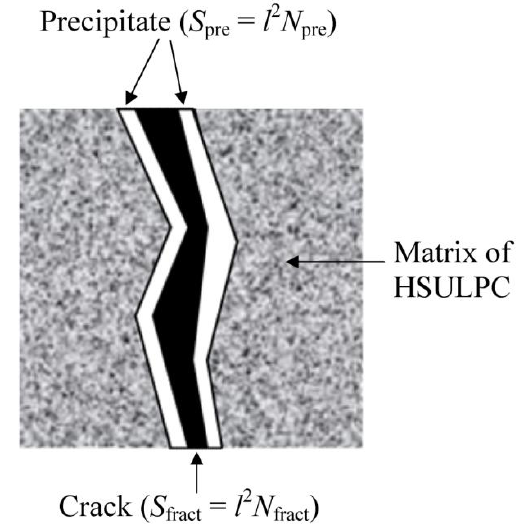
Figure 8. Schematic diagram of precipitation on the fracture surface in each